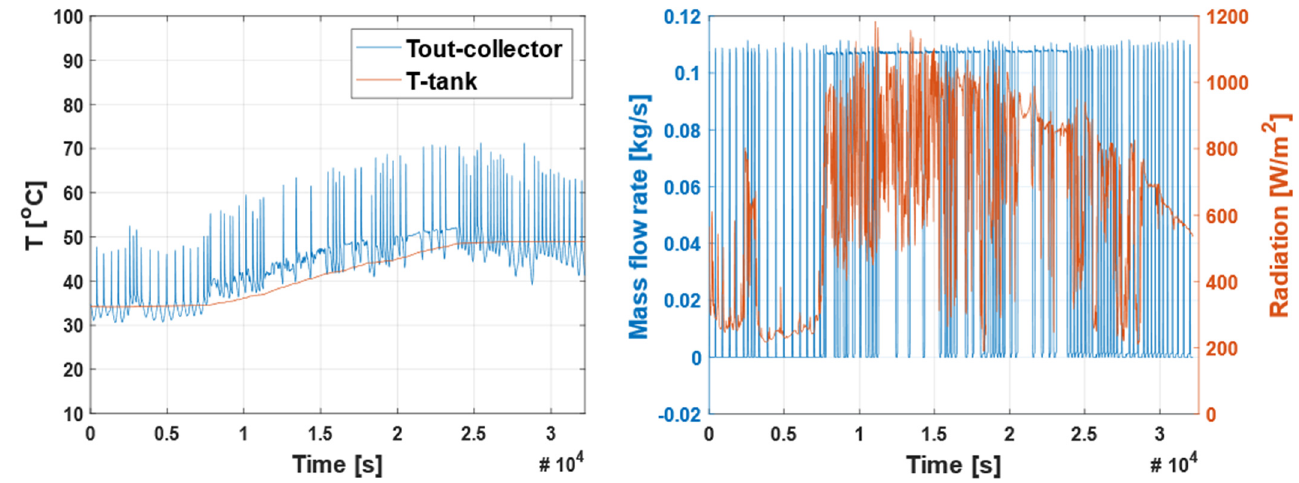
Figure 16. Measurement results of 3.07.